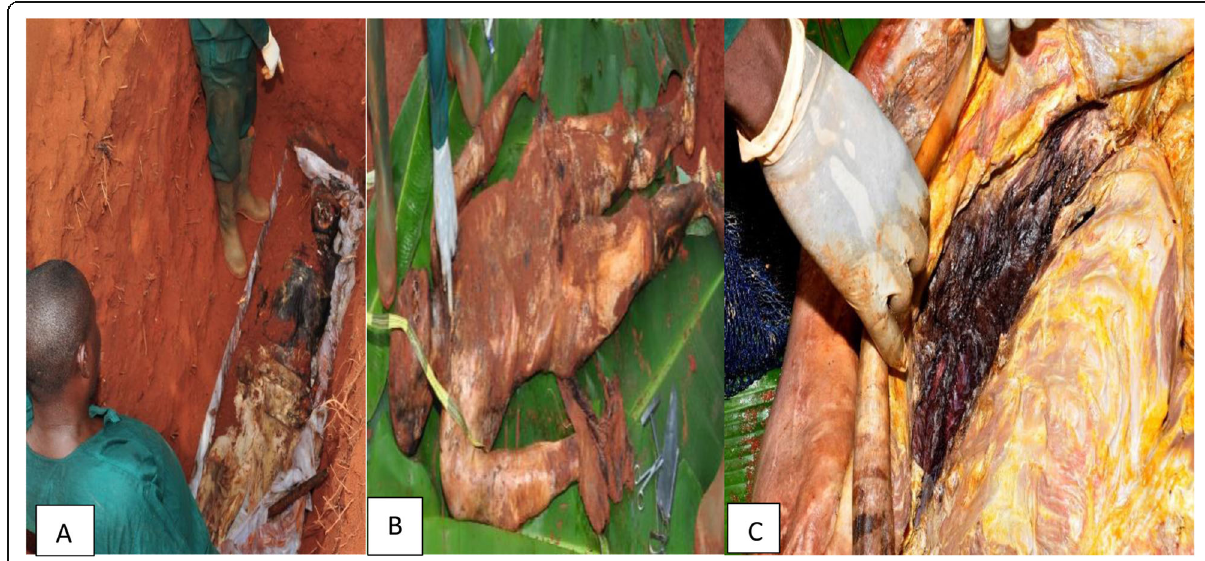
Fig. 2 a The decomposing body inside a casket that all the sides are giving away (disintegration). b Body on the surface, about to be